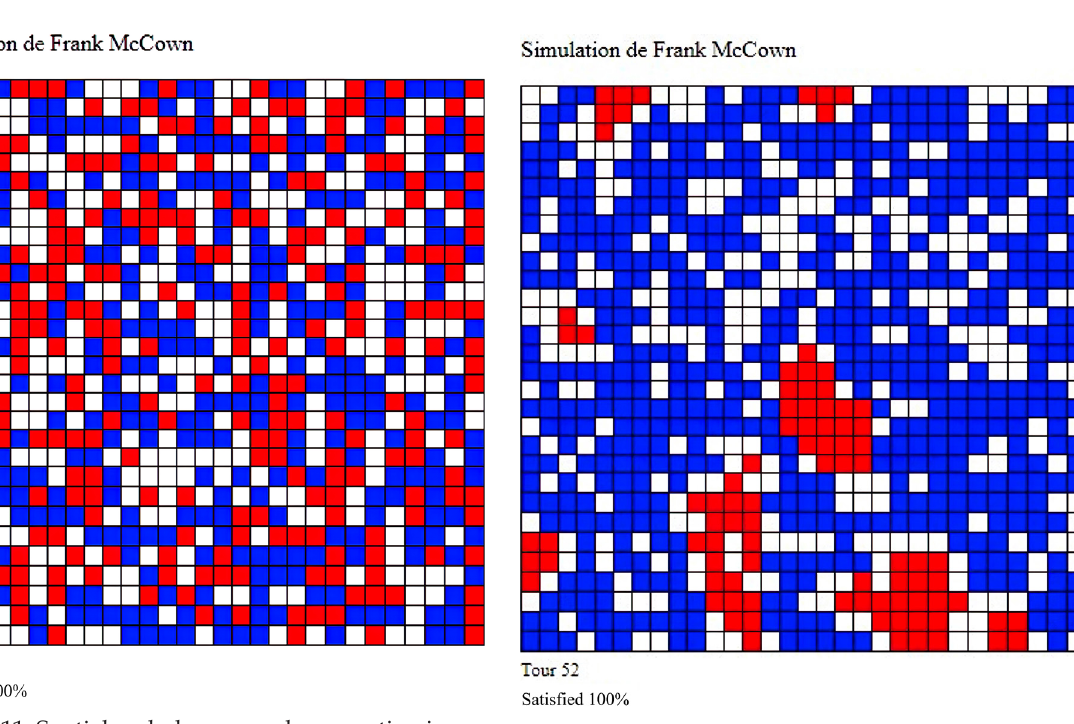
Fig. 13. Spatial and phenomenal segregation in Ghardaïa’s